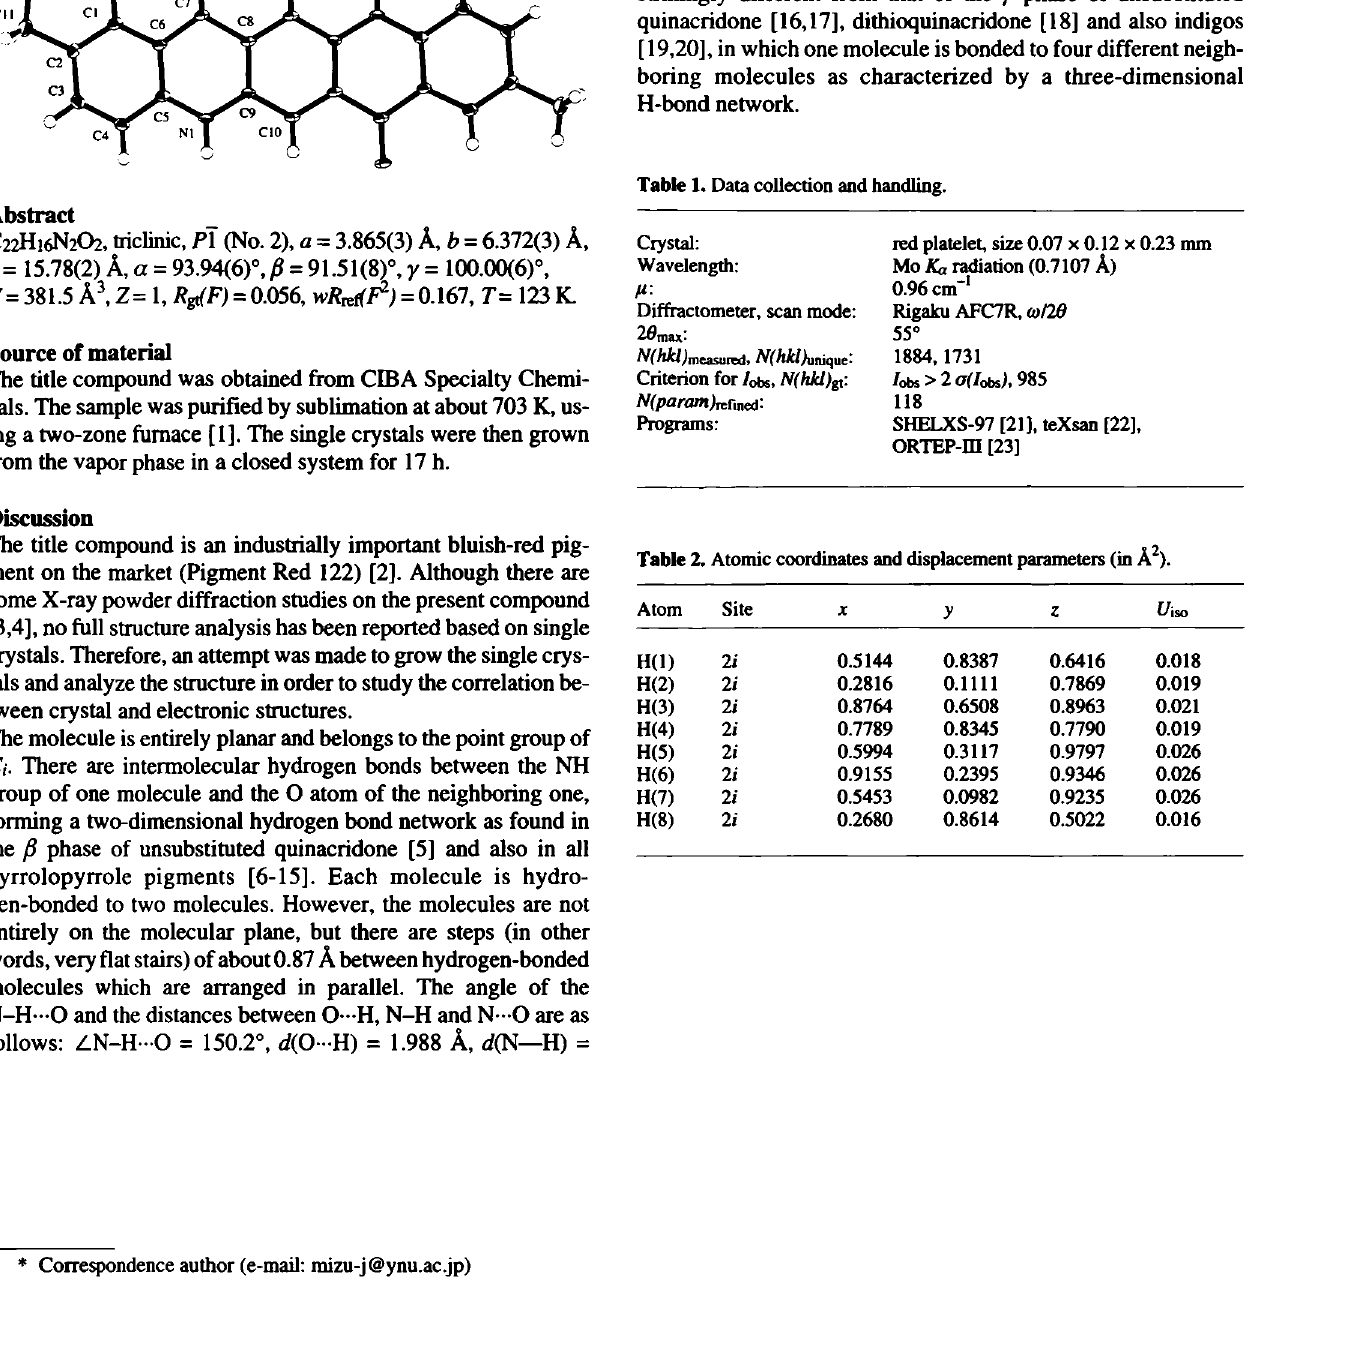
Table 1. Data collection and handling. Crystal: